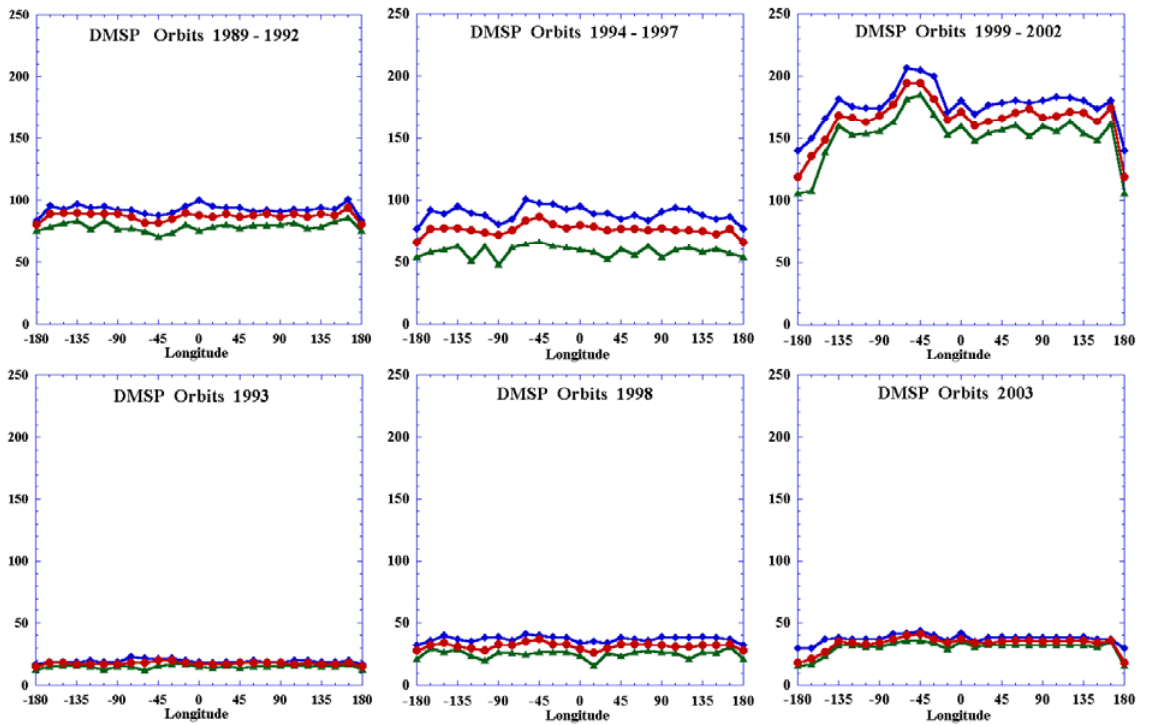
Fig. 2. Plots of the maximum, minimum, and median number of orbits per month sampled in each 15 ° longitude sector for each phase of the solar cycle: maximum 1989-1992, minimum 1994-1997, maximum 1999-2002, and transition years 1993, 1998, and 2003. Data are derived from Tables 2 and 3 for the appropriate years.